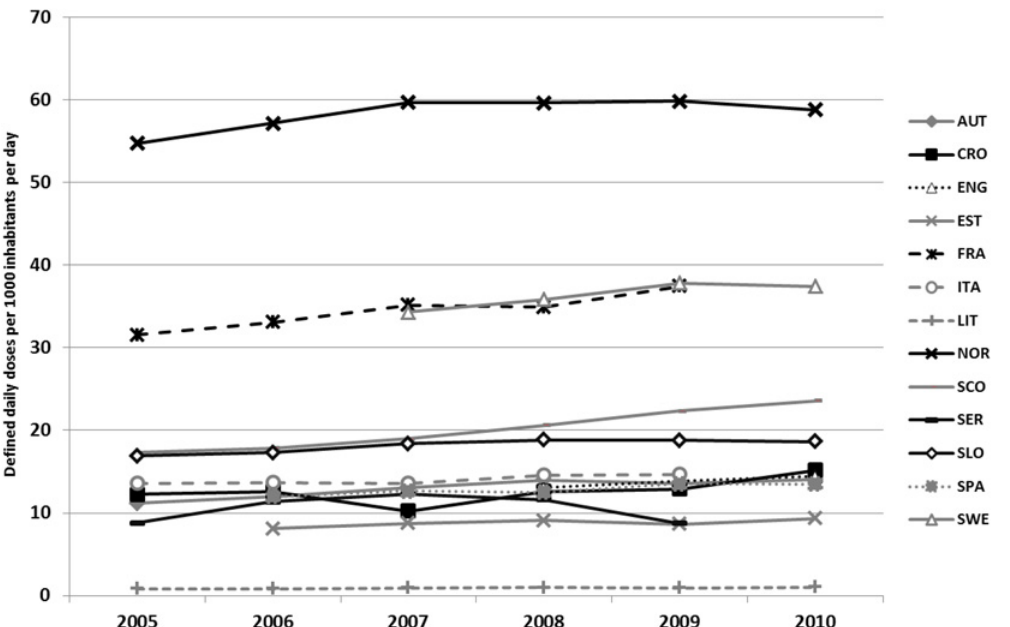
Fig 1. Cross-National Comparison: time trend. AUT: Austria; CRO: Croatia; EST: Estonia; FRA: France; IT: Italy; LIT: Lithuania; NOR: Norway; SPA: Spain (Catalonia); SCO: Scotland; SER: Serbia; SLO: Slovenia; SWE: Sweden. ENG: 2008 – 2010; EST: 2006 – 2010; FRA: 2005 – 2008; ITA: 2006 – 2010; SPA: 2006 – 2010; SWE: 2007 – 2010. Data from Norway and Sweden include also hospital data. Data from Sweden also includes OTC